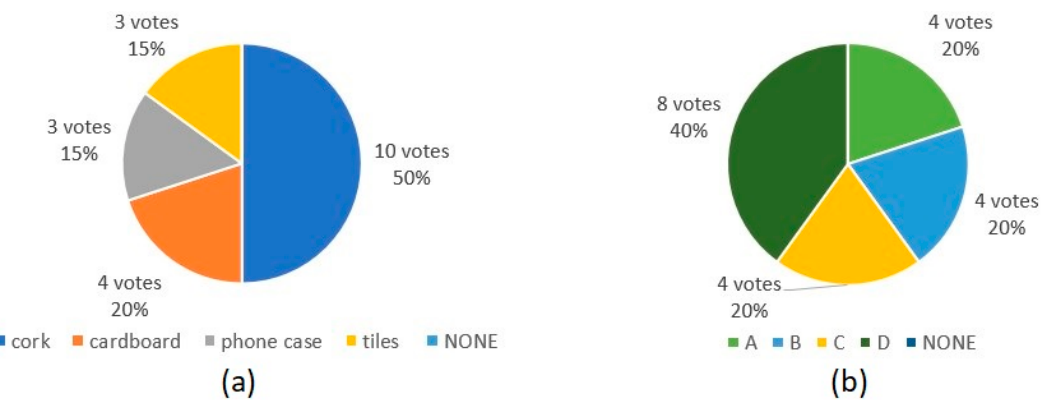
Figure 7. ( a ) Volunteers’ perception of the virtual texture displayed on the touchscreen for test 2. ( b ) Volunteers’ perception about the canvas that better represented the physical texture for test 2. According to survey questions from Appendix A.